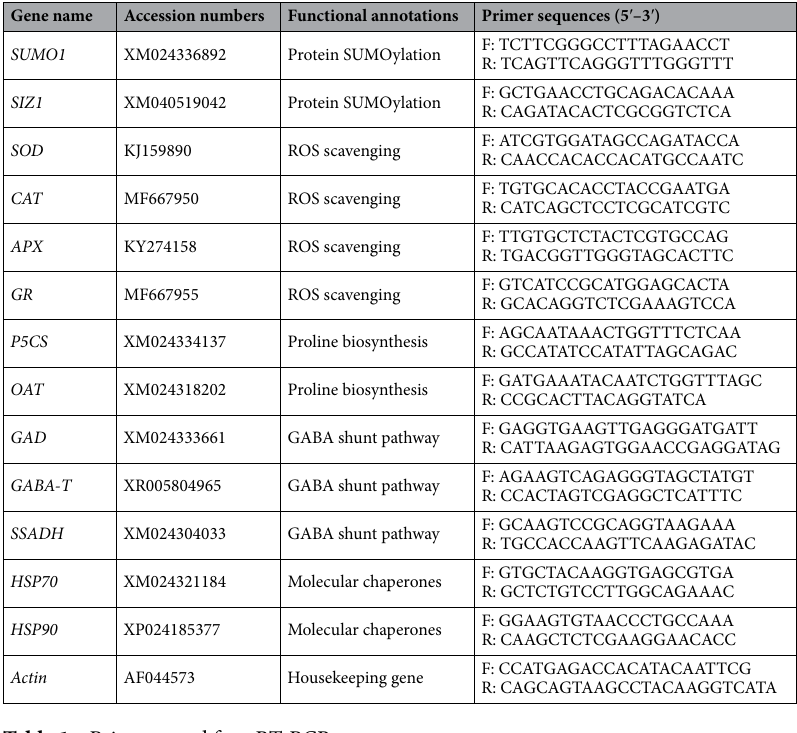
Fig. 1, rose flowers exhibited higher expression of SUMO1 and SUMO E3 ligase SIZ1 ( P < 0.01) during bud open- ing. Matching with higher SUMO1/SUMO E3 ligase SIZ1 genes expression, higher expression and activities ( P < 0.01) of SOD , CAT , APX , and GR were associated with lower endogenous H 2 O 2 accumulation ( P < 0.01) in rose flowers during bud opening (Fig. 1; Table 2). In addition, higher endogenous proline (Table 3) and GABA accumulation (Table 4) ( P < 0.01) in rose flowers during bud opening was concomitant with higher expression and activity P5CS and GAD , respectively (Fig. 1; Tables 3 and 4) ( P < 0.01). SUMO1/SUMO E3 ligase SIZ1 signaling pathway during petal senescence. Harvested rose flow- ers exhibited lower expression of SUMO1 and SUMO E3 ligase SIZ1 (Fig. 1; P < 0.01). Matching with lower SUMO1/SUMO E3 ligase SIZ1 signaling pathway, lower expression and activities of SOD , CAT , APX , and GR ( P < 0.01) were associated with higher endogenous H 2 O 2 accumulation ( P < 0.01) in cut rose flowers during petal senescence (Fig. 1; Table 2). Also, cut rose flowers during petal senescence exhibited lower expression and activ- ity of P5CS ( P < 0.01) concomitant with higher expression and activity of OAT ( P < 0.01), thereby activating endogenous proline accumulation ( P < 0.01) in cut rose flowers during petal senescence (Fig. 1; Table 3). In addition, lower GABA accumulation in cut rose flowers during petal senescence was associated with higher expression and activities of GABA-T and SSADH ( P < 0.01) (Fig. 1; Table 4). PSKα treatment and petal senescence in cut rose flowers. As shown in Fig. 2, reinforcing the expression of SUMO1 and SUMO E3 ligase SIZ1 ( P < 0.01) by 150 nM PSKα treatment might postpone senes-